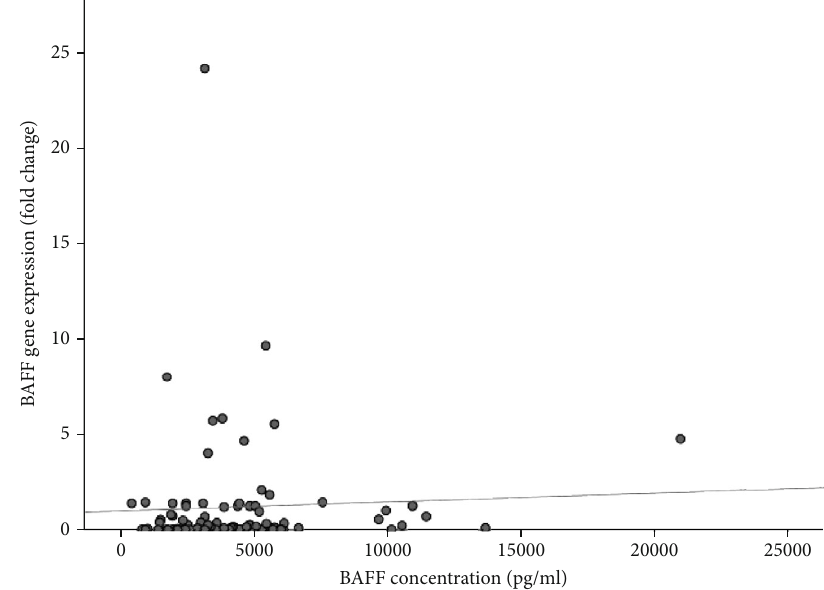
Figure 9: Correlation between serum and mRNA expression levels of